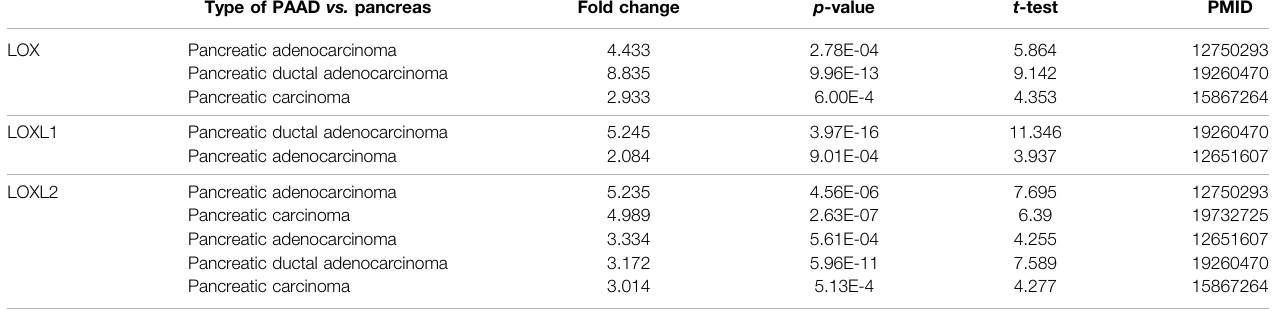
TABLE 1 | The signi fi cant changes of LOXs expression in transcriptional level between PAAD and normal pancreas tissues (Oncomine). Type of PAAD vs. pancreas